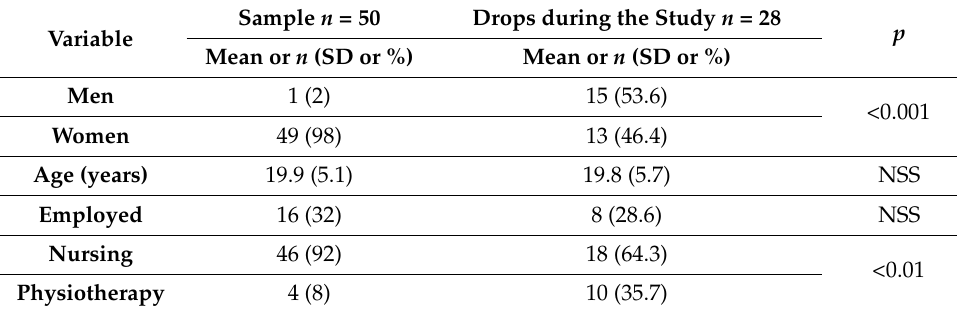
Table 1. Characteristics of the study